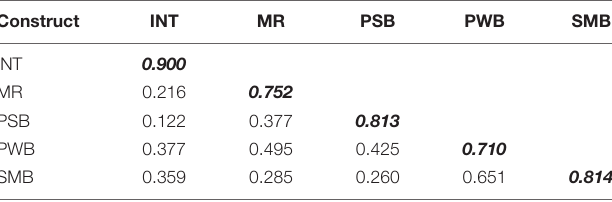
TABLE 2 | Discriminant validity (Fornell and Larcker, 1981 criterion). Construct